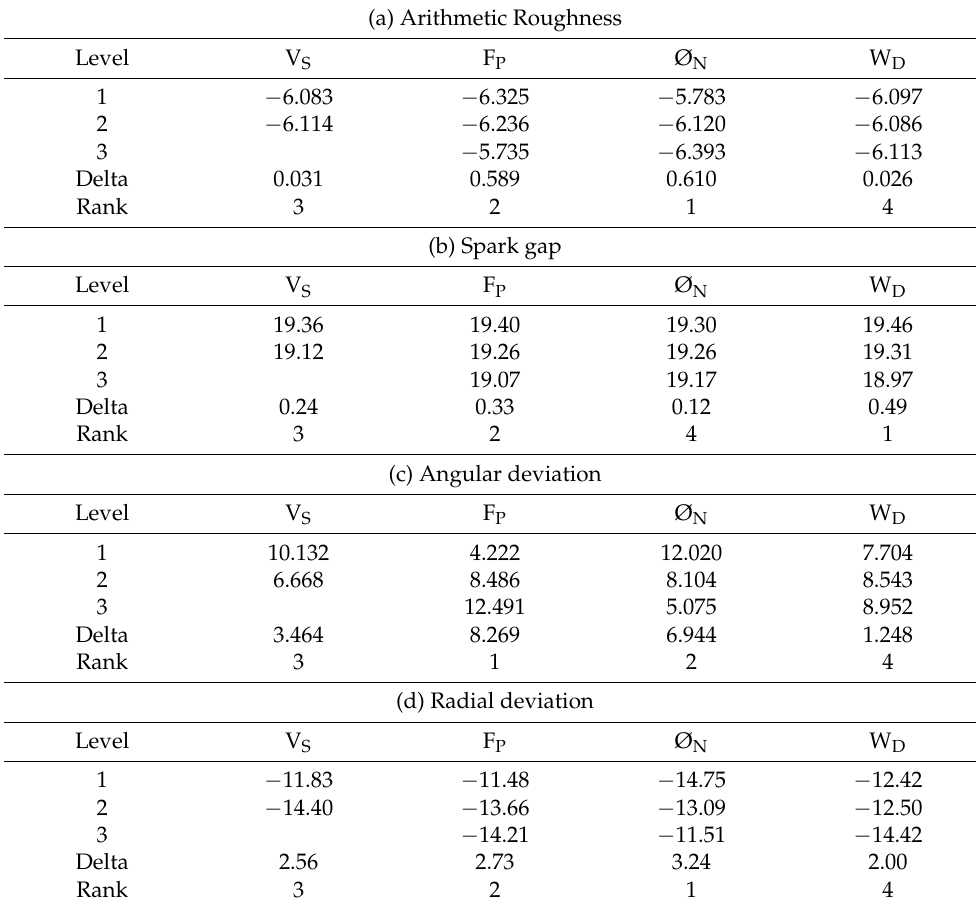
Table 5. Mono-optimization through the signal-to-noise